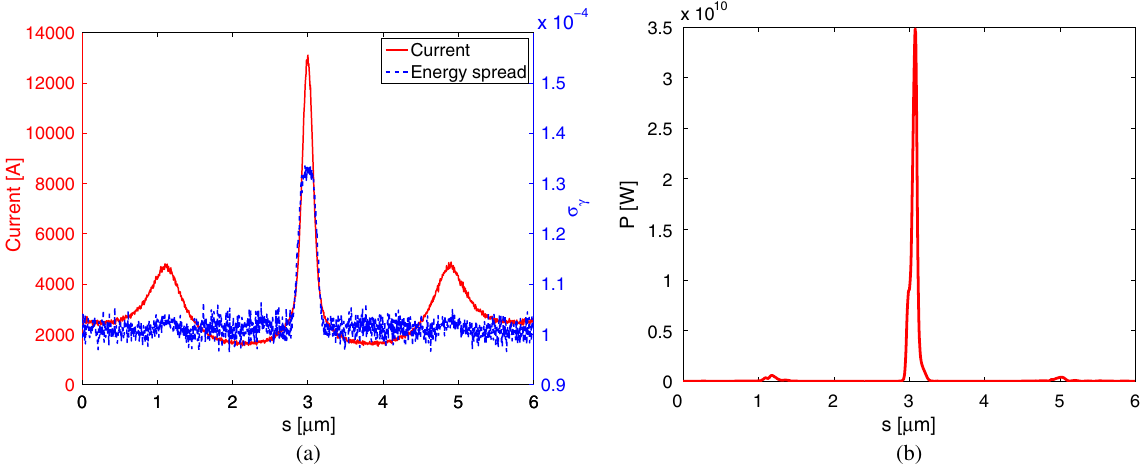
FIG. 9. (a) Current profile (red solid line) and slice energy spread (blue dashed line) at the entrance of the radiator section for the 1.2 cycles modulating laser employed in our proposed scheme. (b) Radiation power at 46.6